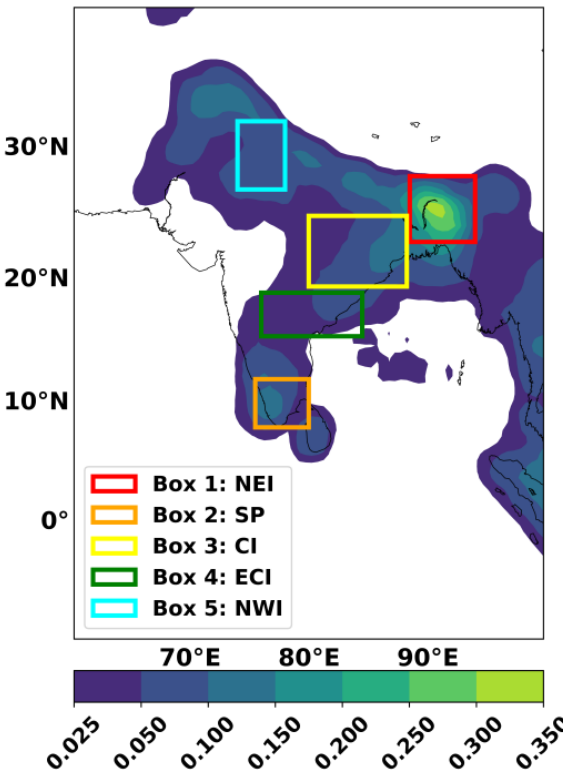
Figure 2. Pre-monsoon (March–April–May or MAM) mean flash rates (flash count km − 2 day − 1 ) ob- tained from Lightning Imaging Sensor (LIS)/Optical Transient Detector (OTD) Gridded 1995–2015 Cli- matology data sets [38]. Colored boxes highlight five thunderstorm-prone regions as defined by [26].